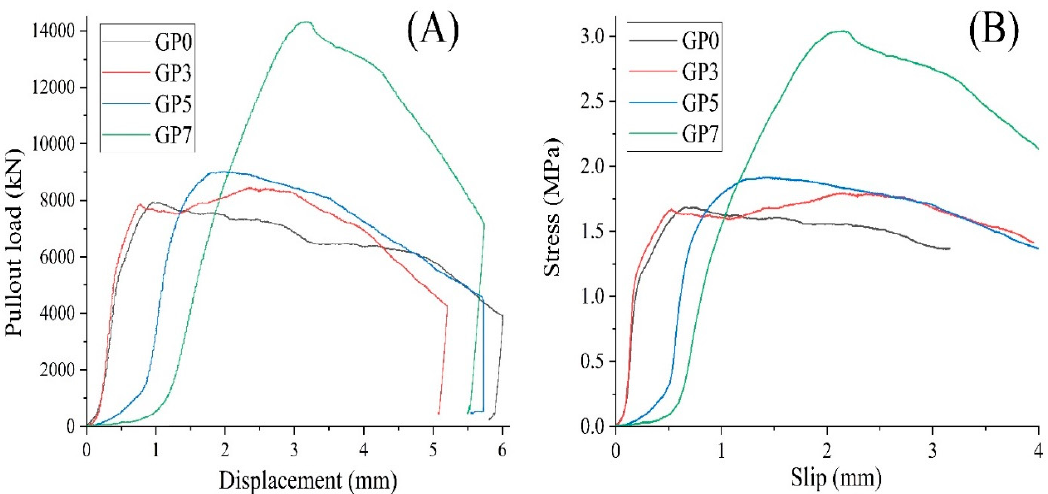
Figure 12. Bond interaction between the matrix and the deformed steel bar explains ( A ) the pullout load—displacement curves; ( B ) the stress-slip curves.